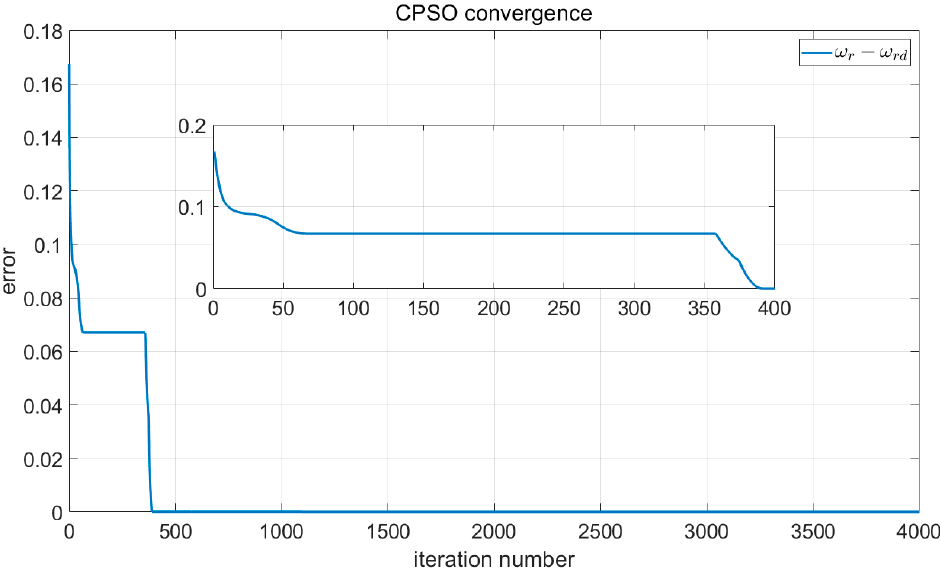
Figure 7. Convergence of the CPSO.